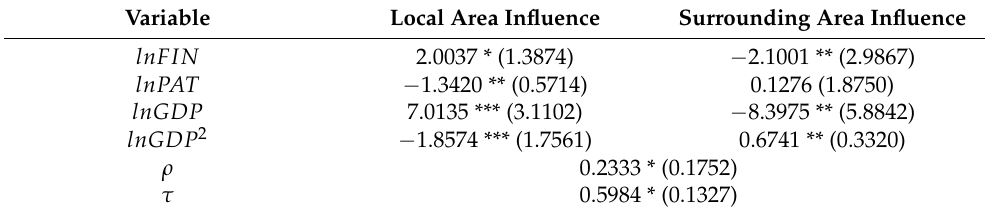
Table 4. Model estimation results without population